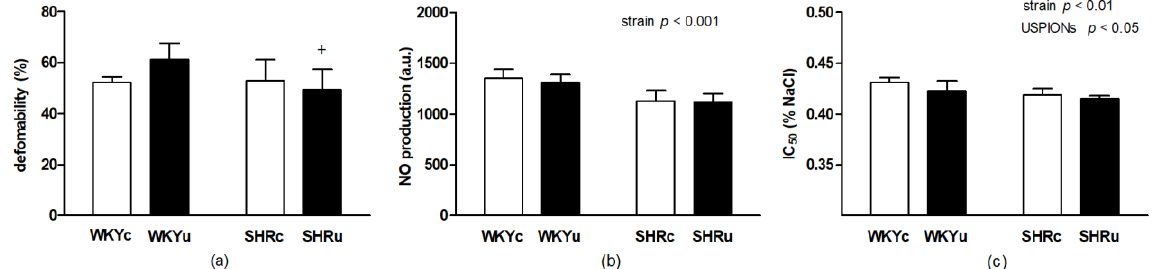
Figure 4. The effect of repeated USPION administration at the dose of 2 mg Fe/kg of body weight per day on RBC properties—deformability ( a ), nitric oxide production ( b ), and osmotic resistance ( c ). Rats were killed approximately 24 h after the second USPION administration. Abbreviations: USPIONs, ultra-small superparamagnetic iron-oxide nanoparticles; WKY, Wistar Kyoto rats; SHR, spontaneously hypertensive rats; WKYc, control WKY; WKYu, USPION-treated WKY; SHRc, control SHR; SHRu, USPION-treated SHR; IC 50 , NaCl concentration at which 50% hemolysis occurred. Results are presented as mean ± SD, n = 6–7 per group. + p < 0.05 vs. WKYu.